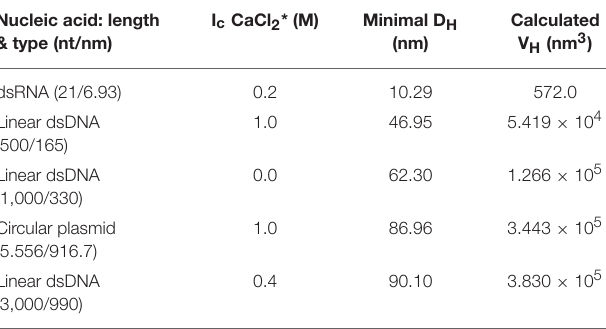
TABLE 2 | Minimally sized nano-complexes and